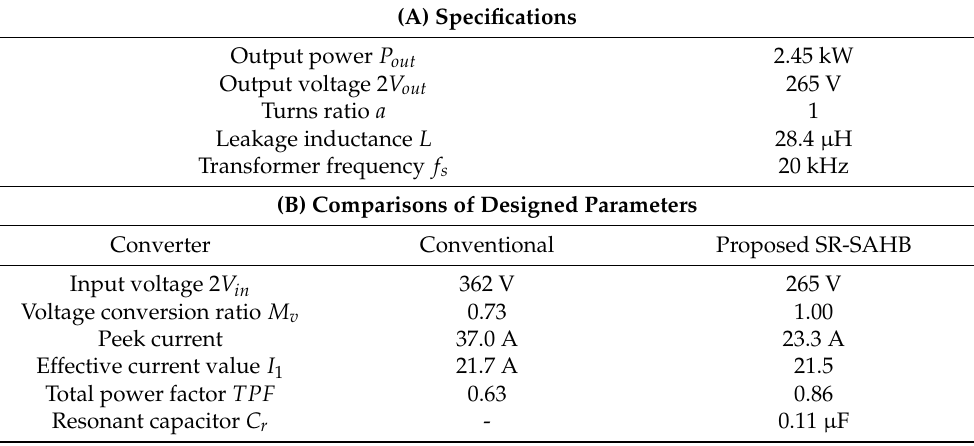
Table 1. Design example of conventional SAHB and proposed SR-SAHB converters on 2.45 kW output